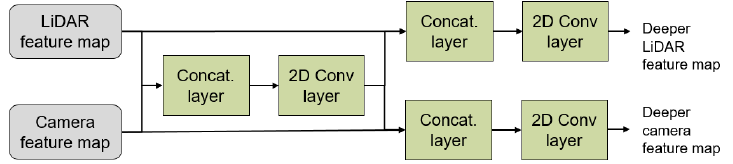
Figure 3. Proposed fusion